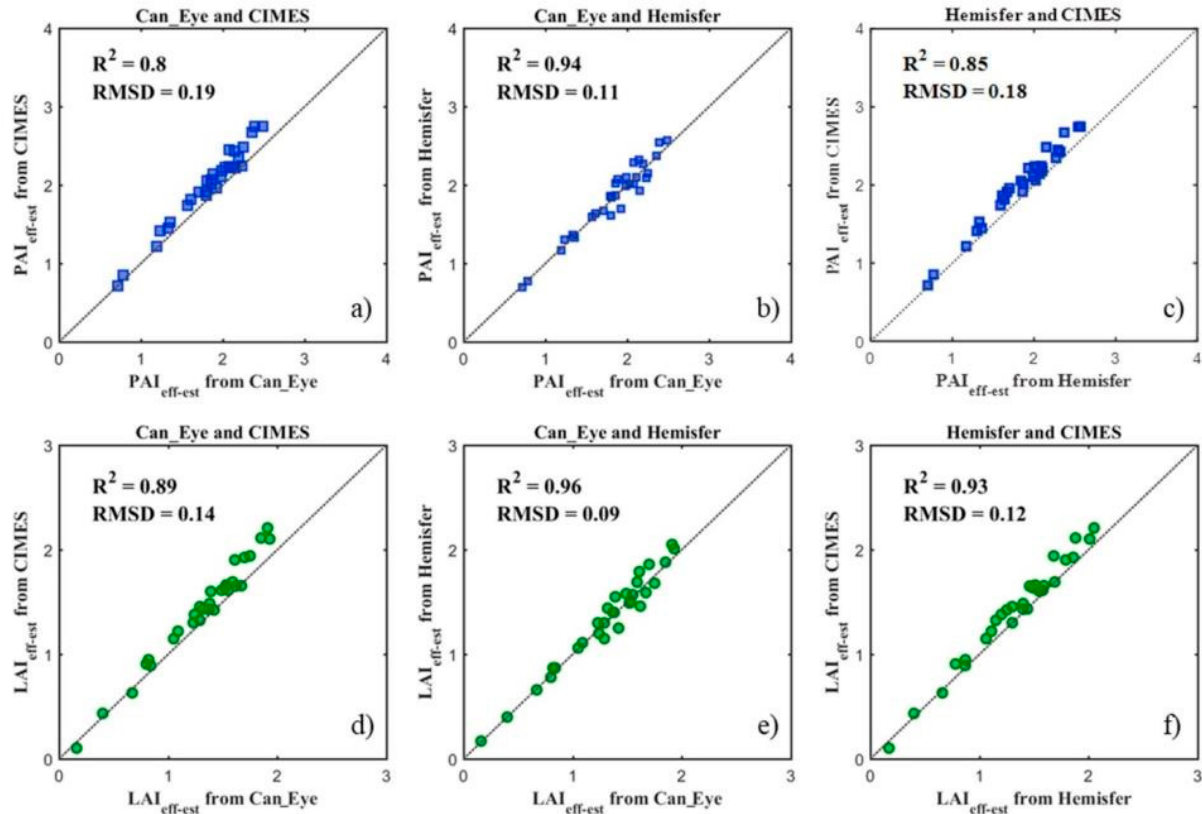
Figure 6. Correlation of the effective plant area index estimates (PAI eff-est ) and effective leaf area index estimates (LAI eff-est ) using three digital hemispherical photography programs (on average, PAI eff-est were 55.8% of the PAI true-ref values, while LAI eff-est were 51.22% of LAI true-ref values).